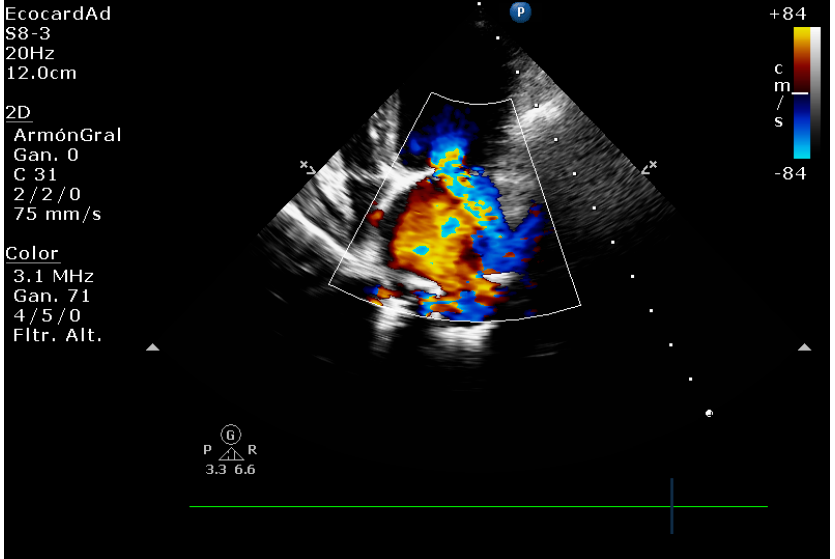
Figure 6. Severe mitral regurgitation in the canine